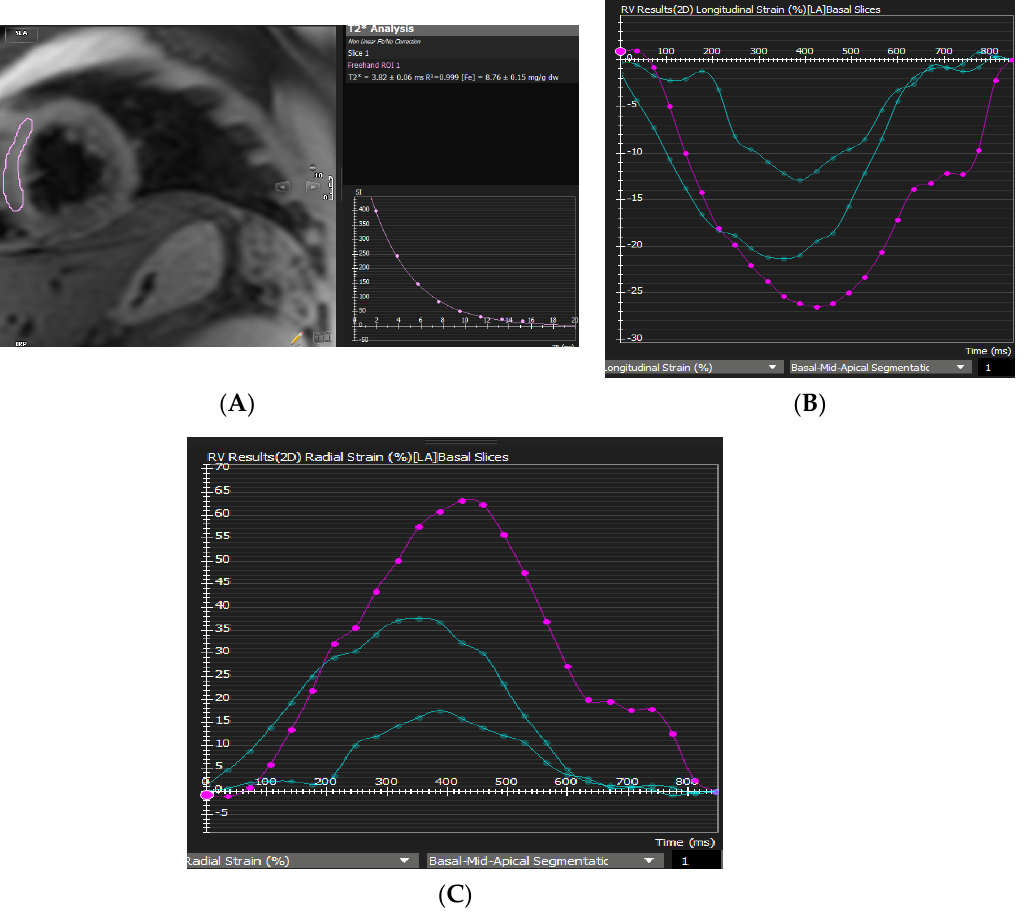
Figure 1. A 16-year-old boy with thalassemia major. ( A ) MIO (T2* 3.8 ms); ( B ) RV GLS; ( C ) GRS. Table 1. Comparison of baseline characteristics in normal and abnormal MIO groups.